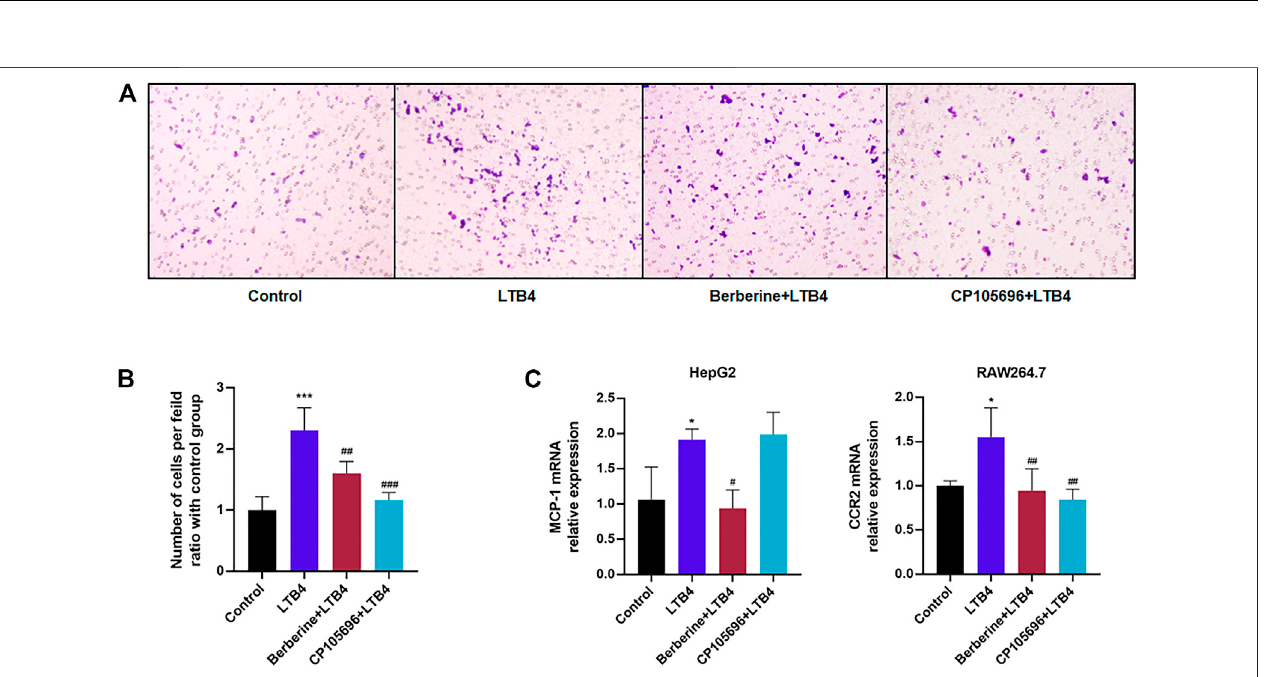
FIGURE4| BBRsuppressedchemotaxisofRAW264.7cellsactivatedbyLTB4. (A) Invitro chemotaxisassaysofRAW264.7macrophageswereperformed.Scale bar, 200 μ m. Cells were fi xed in formalin and stained with crystal violet. (B) The quanti fi ed number of RAW264.7 that were stained in each group ( n (cid:2) 3). (C) Gene expressions of MCP-1 in HepG2 cells and CCR2 in RAW264.7 cells were analyzed by RT-PCR ( n (cid:2) 4). Error bars represent mean ± SD. BBR, Berberine, 10 μ M; CP105696, 10 μ M; LTB4, Leukotriene B4, 200 nM * p < 0.05 vs. Control; # p < 0.05 vs. LTB4. *** p < 0.01; ## p < 0.01; ### p < 0.001.